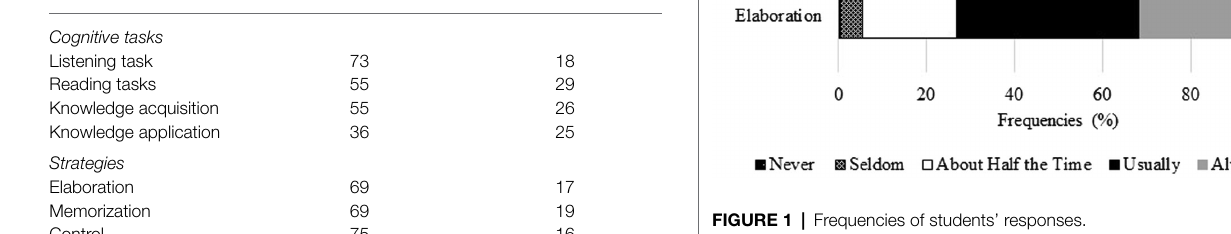
FIGURE 1 | Frequencies of students’